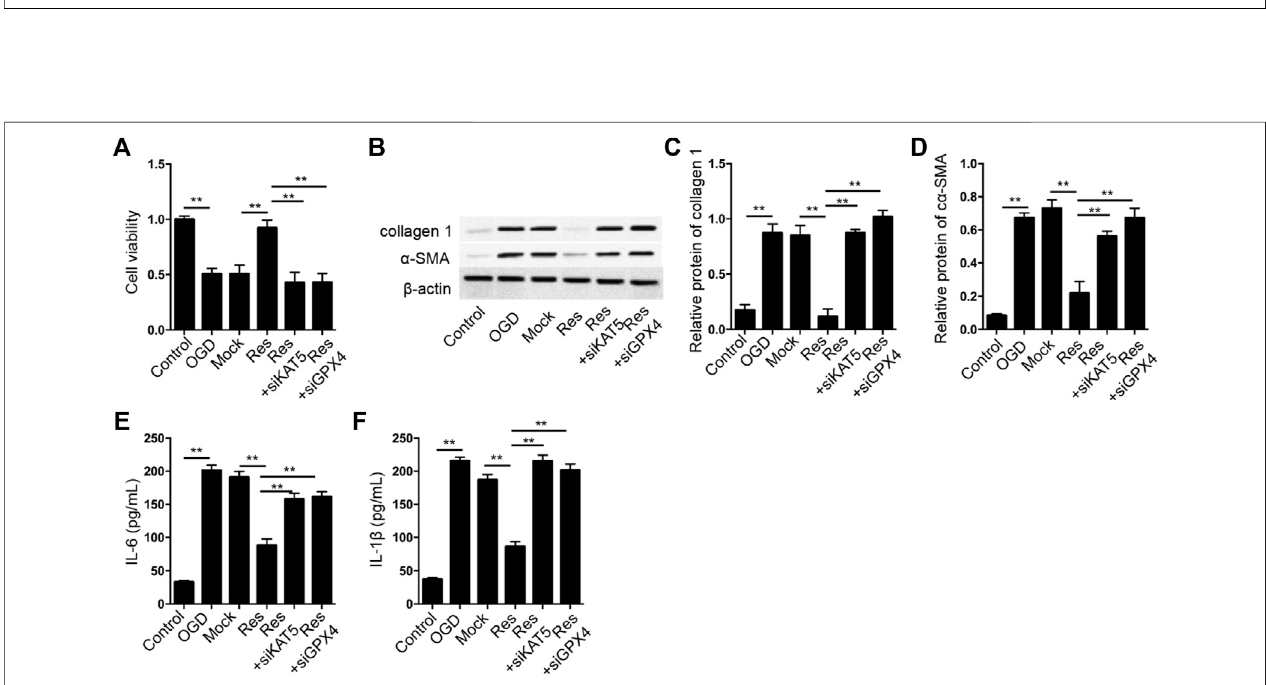
FIGURE7| ResrelievesOGD-inducedcardiomyocyteinjurybyKAT5/GPX4signaling .(A – F) TheOGD-treatedH9c2cellsweretreatedwithRes,orco-treatedwith GPX4or SLC7A11siRNA. (A) Thecell viabilitywasmeasuredbyCCK-8assay. (B – D) Theexpression ofcollagen1and α -SMAwastested byWesternblotanalysisand wasnormalizedontheexpressionof β -actin. (E,F) ThelevelsofIL-6andIL-1 β weredetectedbyELISA.Dataarepresentedasmean±SD.Statisticsigni fi cantdifferences were indicated: ** p < 0.01.